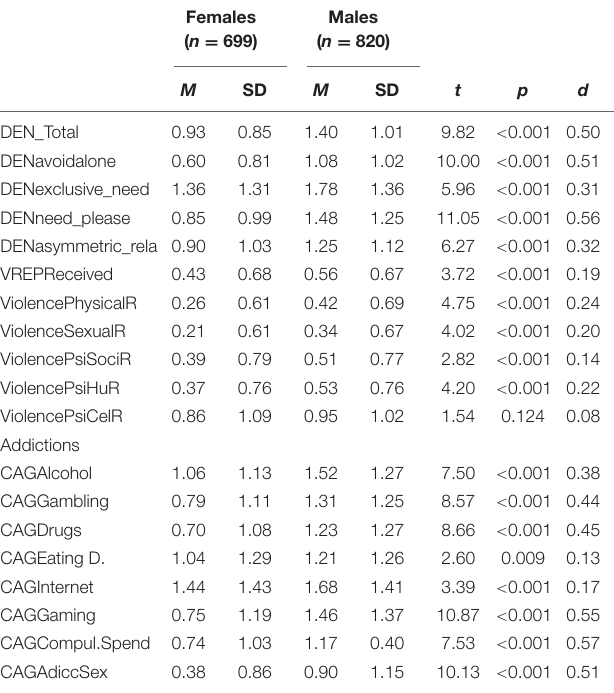
TABLE 1 | Descriptive statistics and mean differences between women and men.